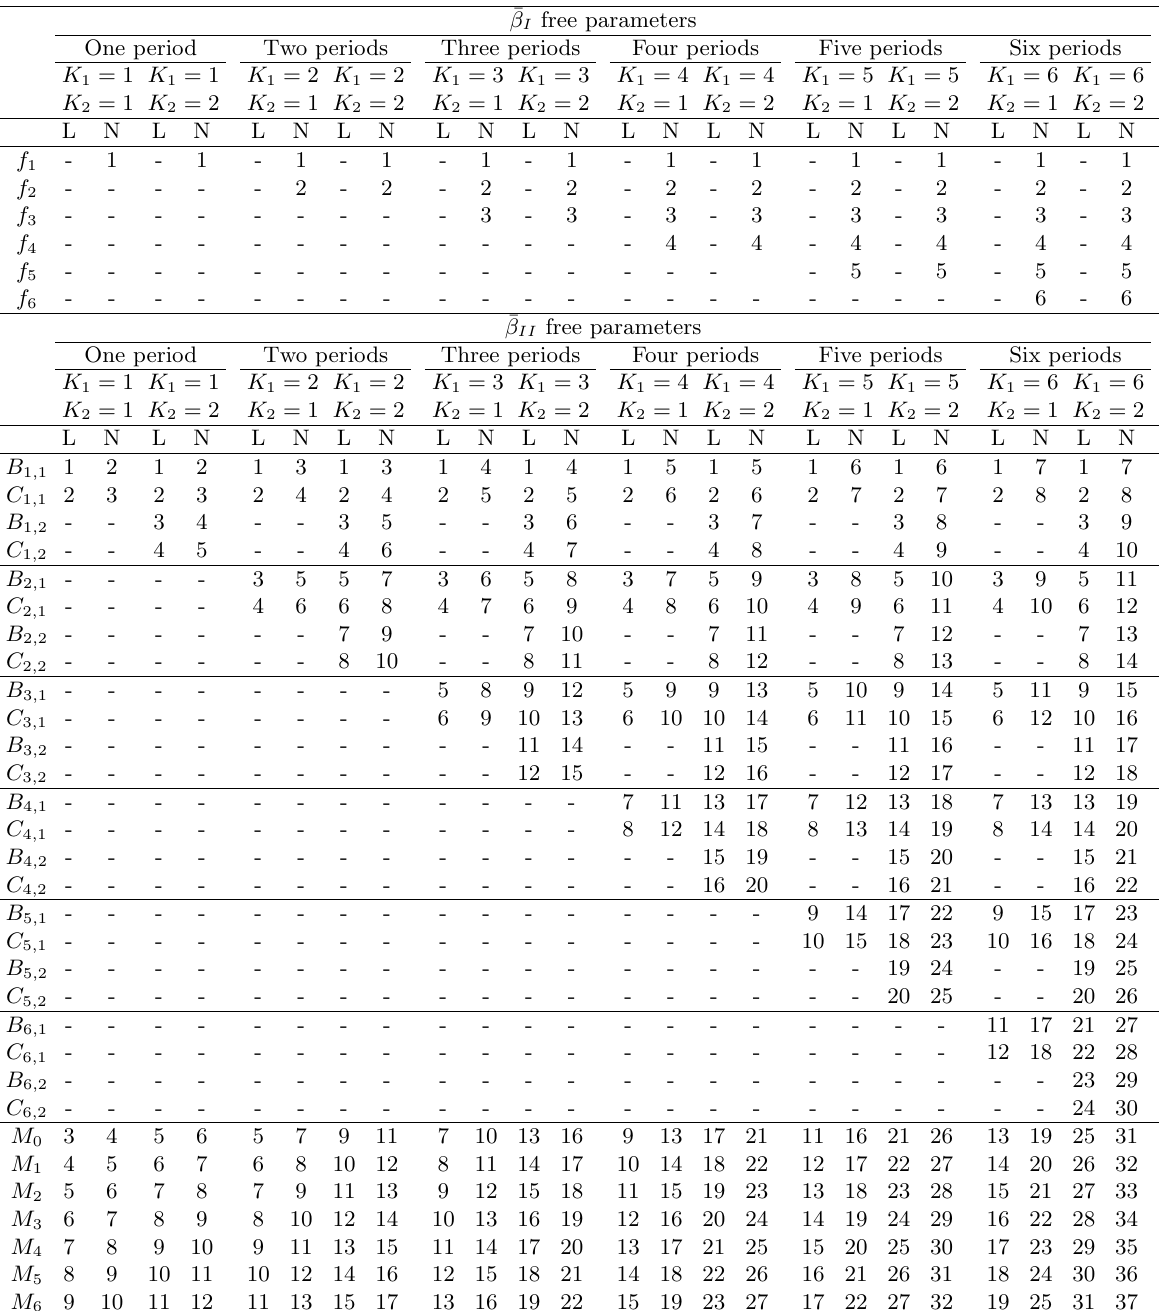
and ¯ β . Columns “L” and “N” I II and K 1 2